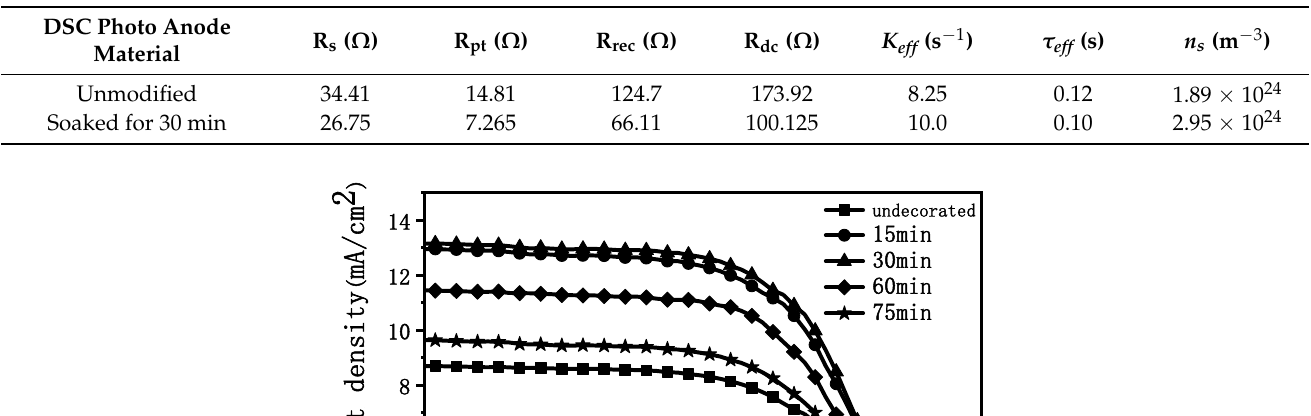
Table 2. Electron transport kinetics microscopic parameters of DSC before and after adding TiO 2 particle surface-modification layer.